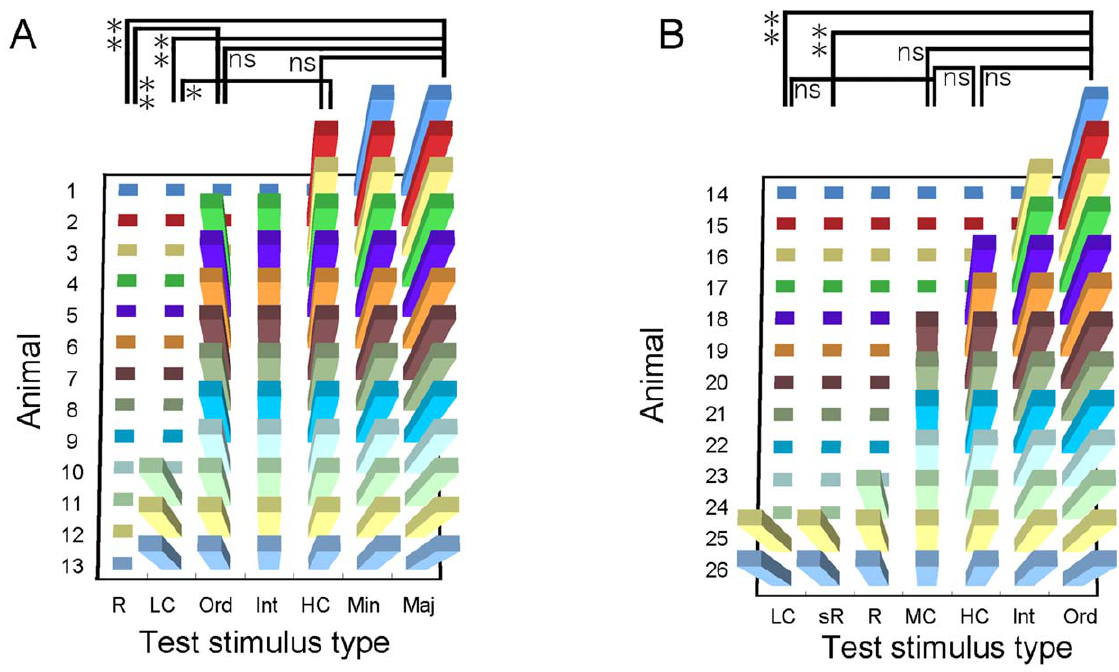
Figure 5. Graphs displaying the presence (bar) or absence (square) of the behavioral reactions to different pseudo-target sounds. Slightly different stimulus sets (x-axes) were prepared for 2 separate groups of animals ( A , 1st test, n=13; and B , 2nd test, n=13) (y-axes). The pseudo-target sounds used in the recognition tests are shown on the x-axes. ‘‘Maj’’ and ‘‘Min’’; modified step sounds with 7 major and 7 minor segments of the step sound doubled. ‘‘Int’’; modified step sound with the intersegment intervals expanded. ‘‘Ord’’; modified step sound with the segment-order shuffled. ‘‘LC’’, ‘‘MC’’ and ‘‘HC’’; modified step sounds with the low-, mid-, and high-frequency range removed from the step sound, respectively. ‘‘R’’ and ‘‘sR’’; modified step sounds with the entire sound reversed in time and with individual segments locally time-reversed, respectively. *, p , 0.05 and **, p , 0.01 and n.s., not significant on a non-parametric statistical test (see text for statistical details).